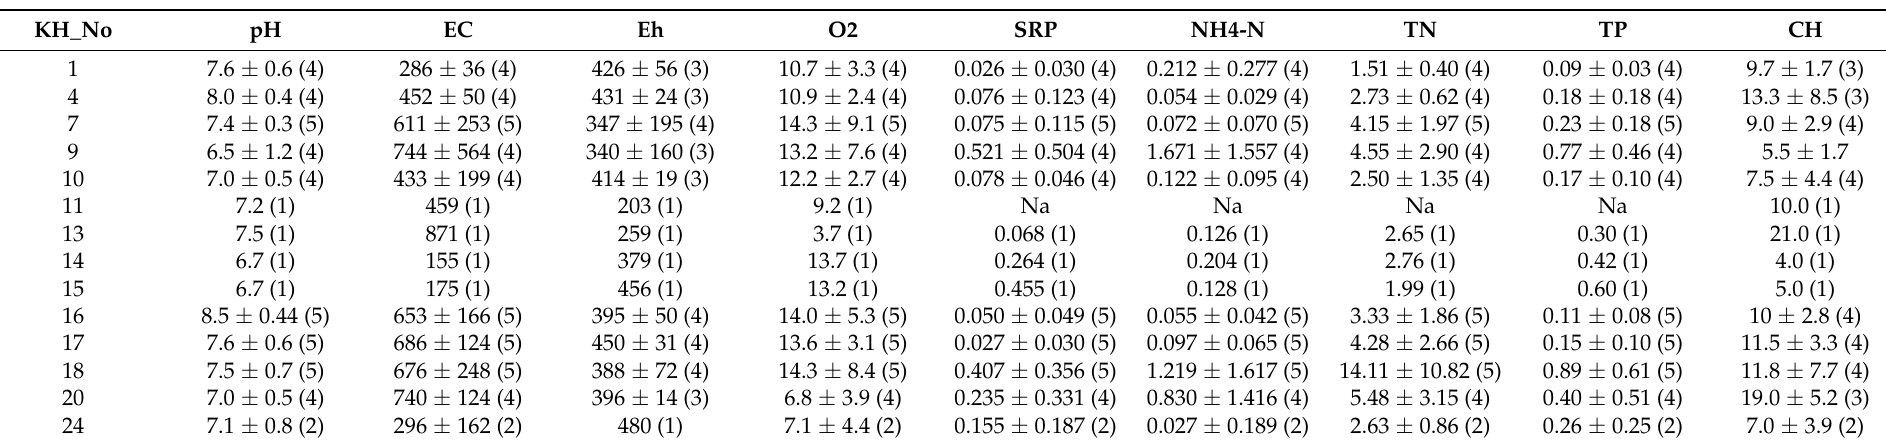
Table 2. Summary of water quality parameters for spring 2016, 2017, 2019 and 2020 as well as summer 2018 with ± 95% confidence intervals and number of values in brackets. KH_No = kettle hole number according to numbering within the SWBTrans project (ZALF), EC = conductivity in µ S/cm, Eh = redox potential in mV, O2 = oxygen in mg L − 1 , SRP =